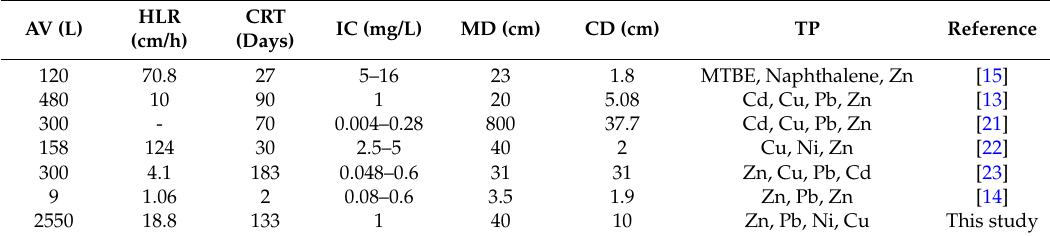
Table 4. Experimental characteristics of similar column studies. AV stands for average volume per column, HLR for hydraulic loading rate, CRT for column running time, IC stands for input concentration, MD for media depth, CD for column diameter, and TP for target